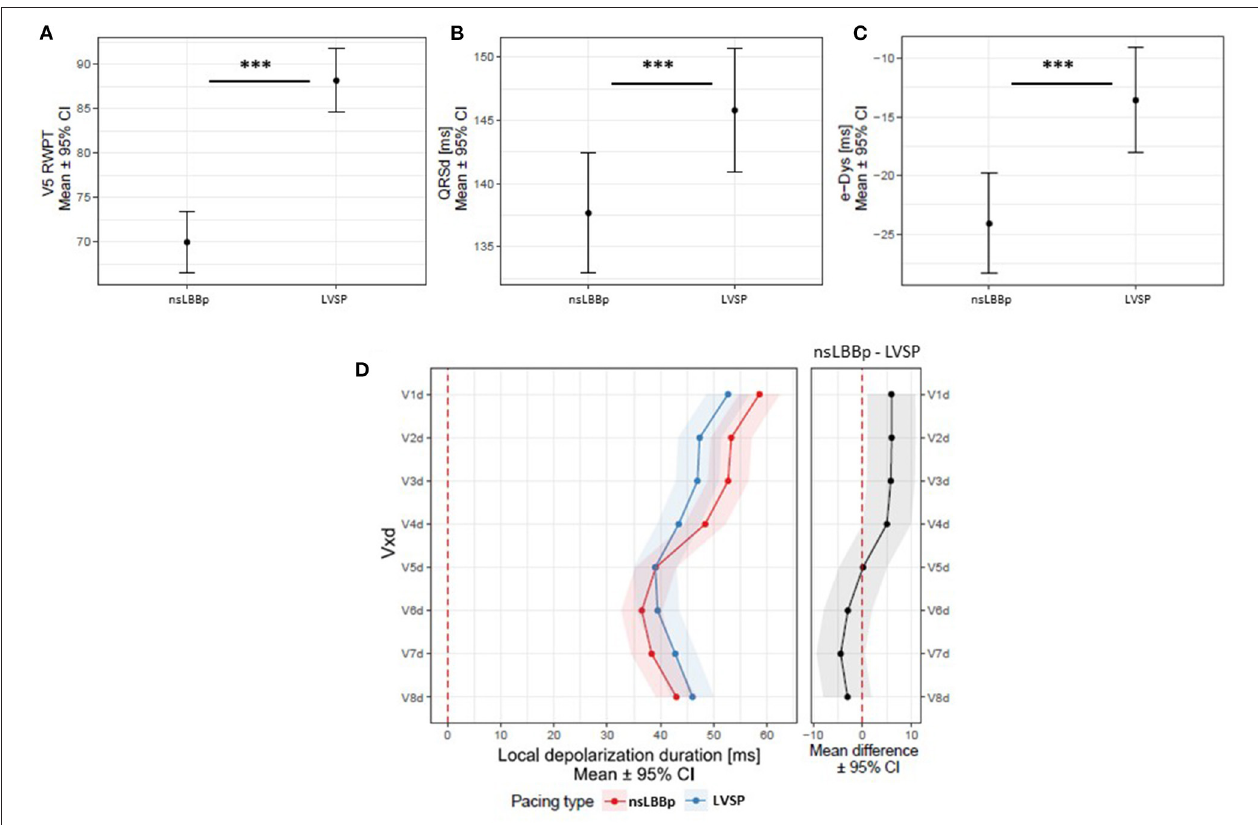
FIGURE 5 | (A) V5 RWPT, QRSd (B) , e-DYS (C) , and local depolarization durations (Vd in V1–V8) (D) between nsLBBp and LVSP with normal heart axes. *** p <